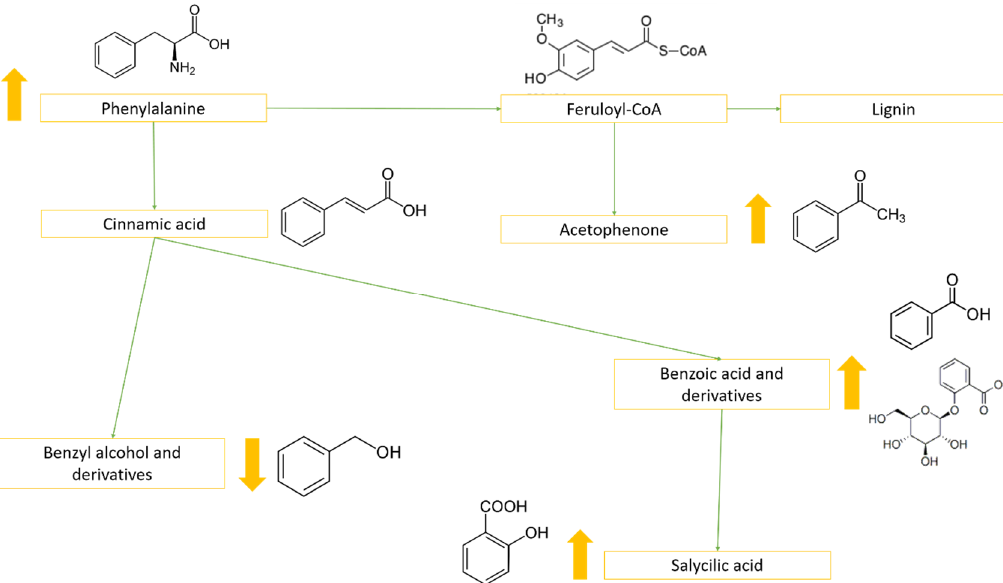
Figure 5. Main biosynthetic pathway steps highlighting the relationships among phenylalanine (PHE), the phenylpropanoid pathway, acetophenone, benzoic acid and its glycosides, and salicylic acid (SA). Yellow arrows indicate the variations during WS exposition.